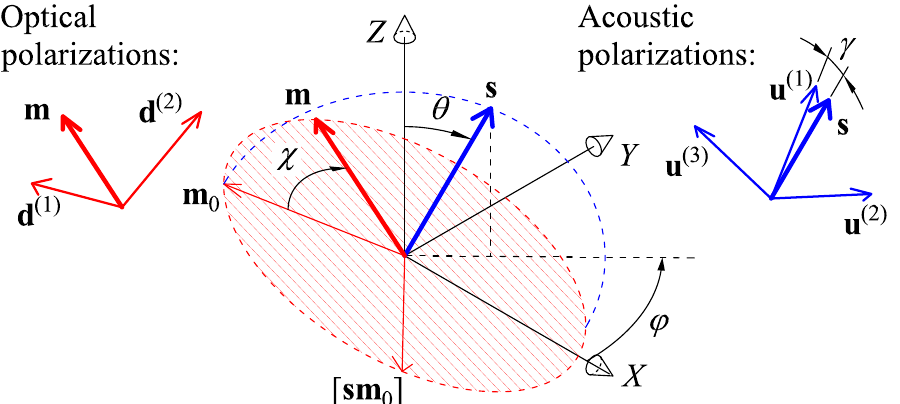
Figure 2. Spatial diagrams for M 2 calculations: a selection of acoustic and optical wave propagation directions and polarizations of optical and acoustic waves. Dashed plane is orthogonal to the acoustic direction unit vector s . The locus of optical wave normal vectors m for the given acoustic wave vector direction s is shown with